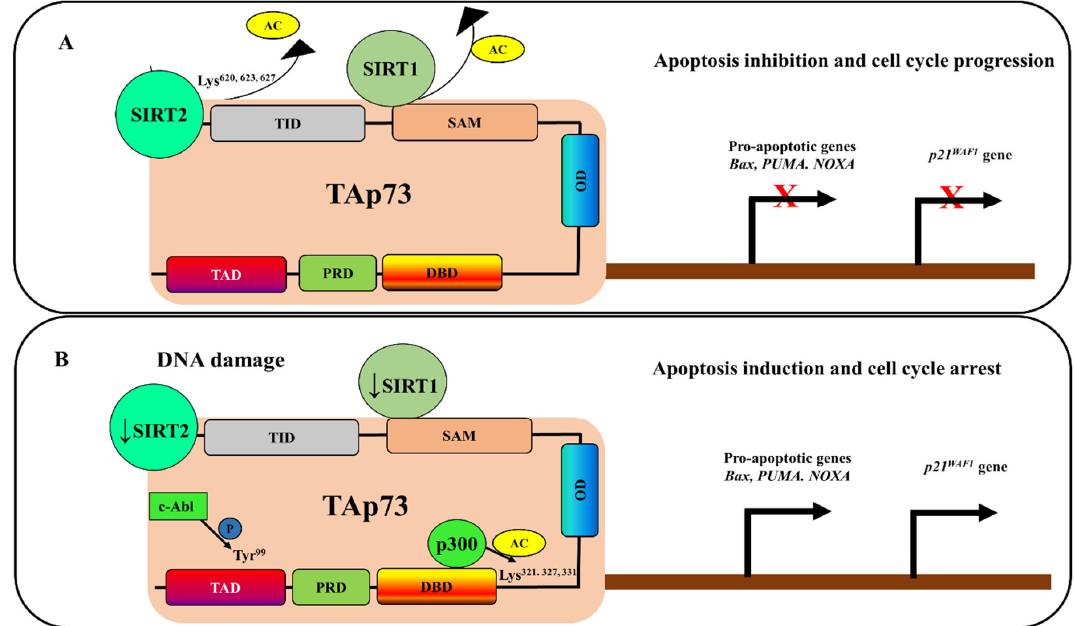
Figure 4. Schematic model of the role of the acetylation pathway in TAp73 regulation . ( A ) SIRT2 can bind to p73α and suppress its transcriptional activity through the deacetylation of several lysine residues located in the p73α C - terminal region: Lys 620,623,627 . SIRT1 can also bind to and deacetylate the p73 protein to inhibit apoptosis and promote cell cycle progression through the inhibition of the pro-apoptotic genes Bax , PUMA, and NOXA and the cell cycle inhibitor p21 WAF1 gene. ( B ) In response to DNA damage, the expression of SIRT1 and SIRT1 proteins is downregulated, while the acetyltransferase p300 is activated and its binding to TAp73 is promoted. TAp73 is then acetylated at several lysine 321,327,331 positions. The p300-mediated TAp73 acetylation is boosted by its phosphorylation at tyrosine 99 by c-Abl, thereby promoting p73 activity and stability. The end result is an induction of apoptosis through the reactivation of Bax, PUMA, and NOXA and the arrest of the cell cycle via the activation of p21 WAF1 .